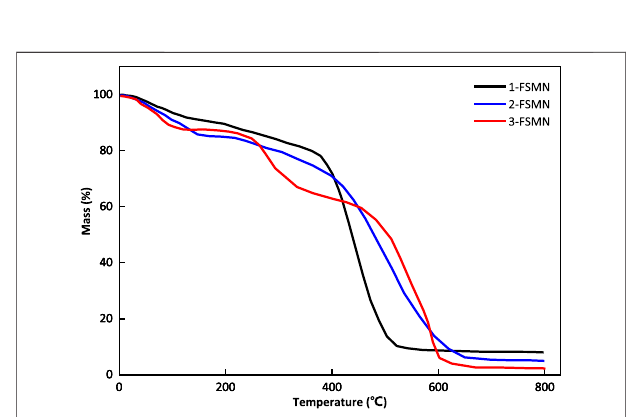
FIGURE 8 | Thermogravimetric curves of 1-FSMN, 2-FSMN, and 3- FSMN materials.